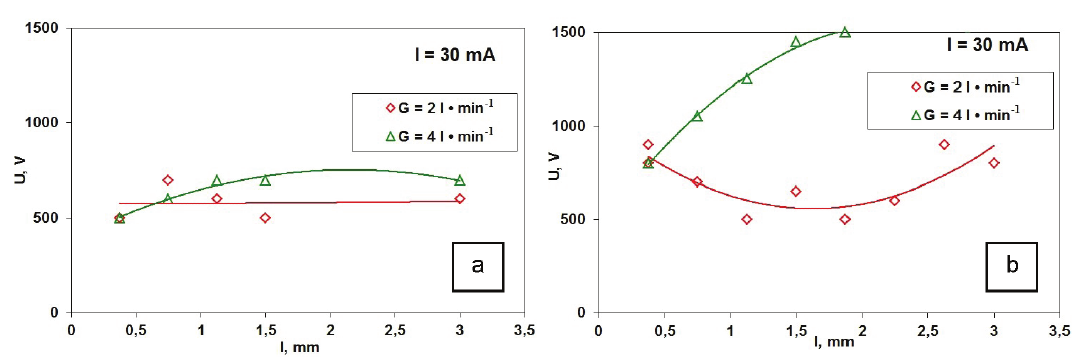
Figure 4: The dependence of the microdischarge voltage (U) on the interelectrode gap ( l ) at the fi xed discharge current (І = 30 mА) for diff erent air flow G and polarities of the flat electrode with outlet of 1.7 mm diameter: a) positive; b) negative.